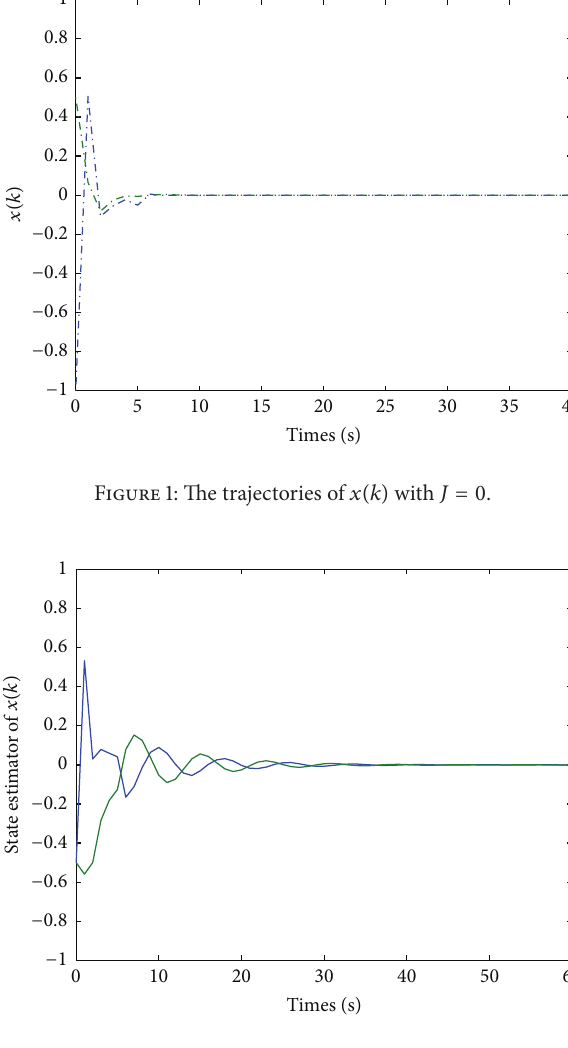
Figure 2: The trajectories of ̃𝑥(𝑘) with 𝐽 = 0 .